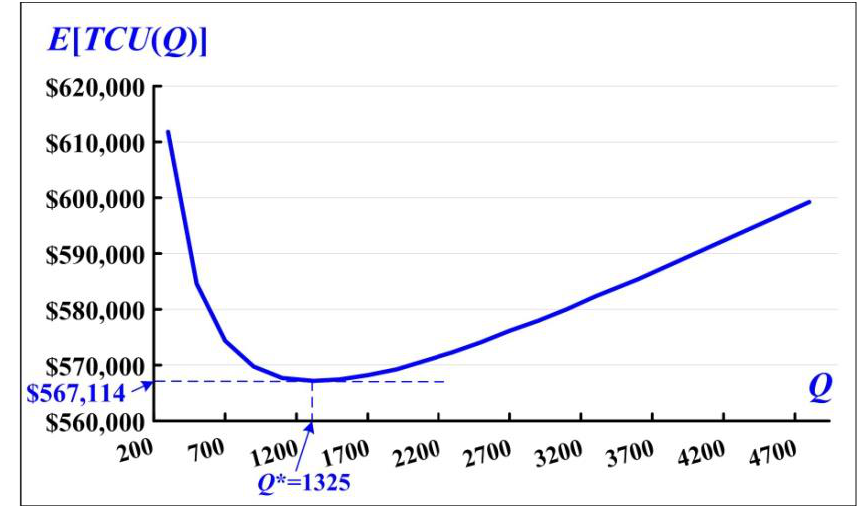
Figure 4. The result of the sensitivity analysis of decision variable Q effects on E[TCU(Q)]